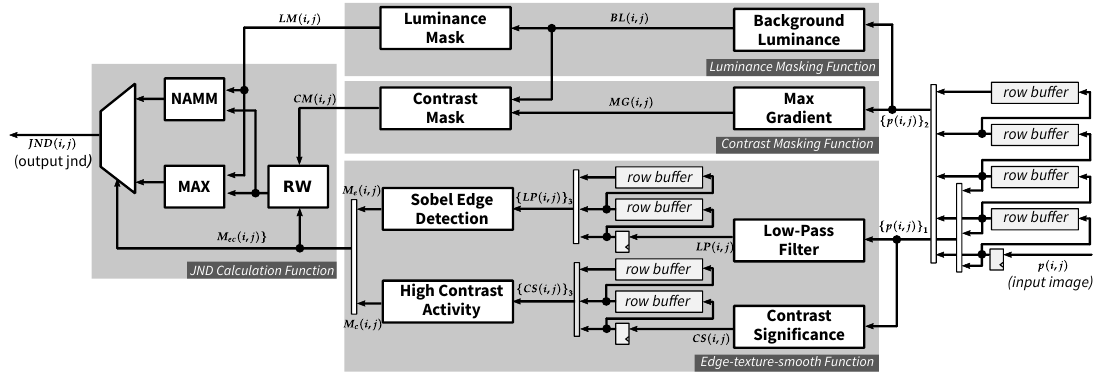
Figure 9. Overall architecture of the proposed JND